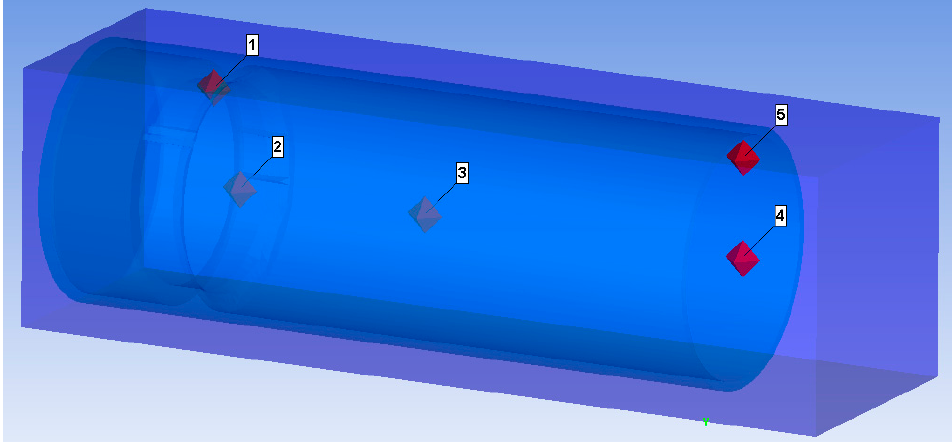
Figure 5. Distribution of Gaussian point positions in the arcing cylinder.